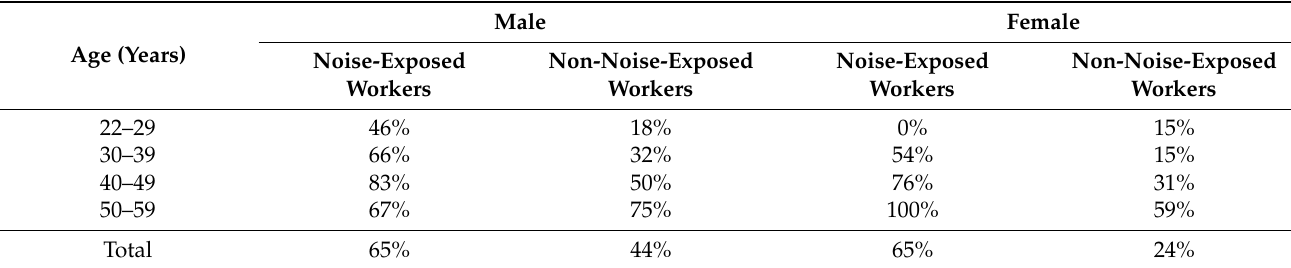
Table 2. Prevalence of audiograms with a high-frequency notch configuration by group, age, and gender of the study